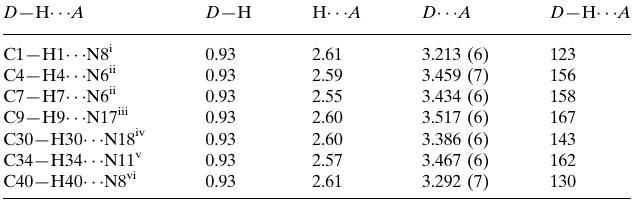
Hydrogen-bond geometry (A˚ , (cid:2)